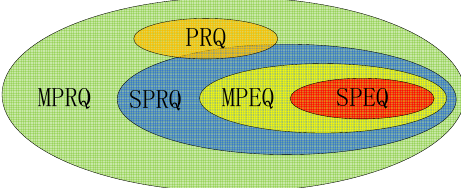
Figure 5. The relationship between SPEQ, MPEQ, PRQ, SPRQ and